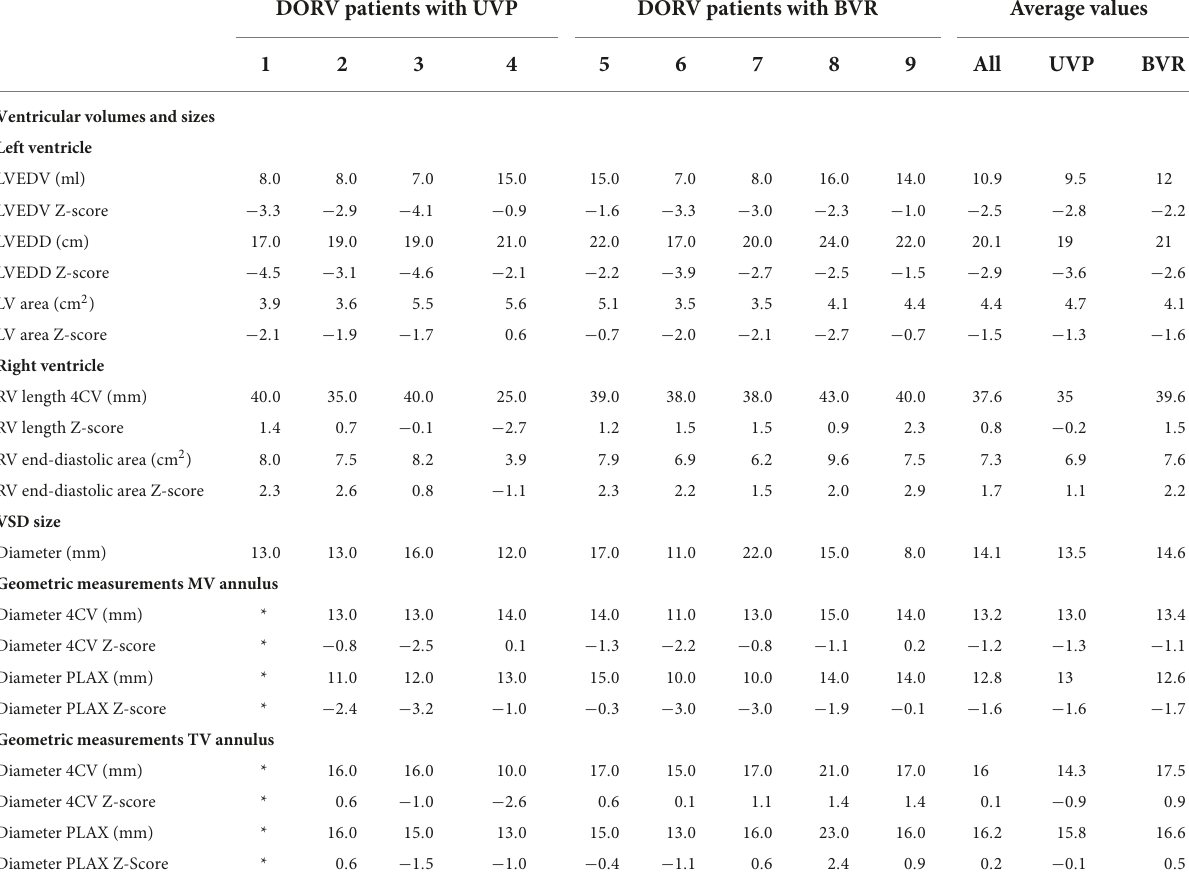
TABLE 2 Preoperative echocardiographic characteristics. DORV patients with